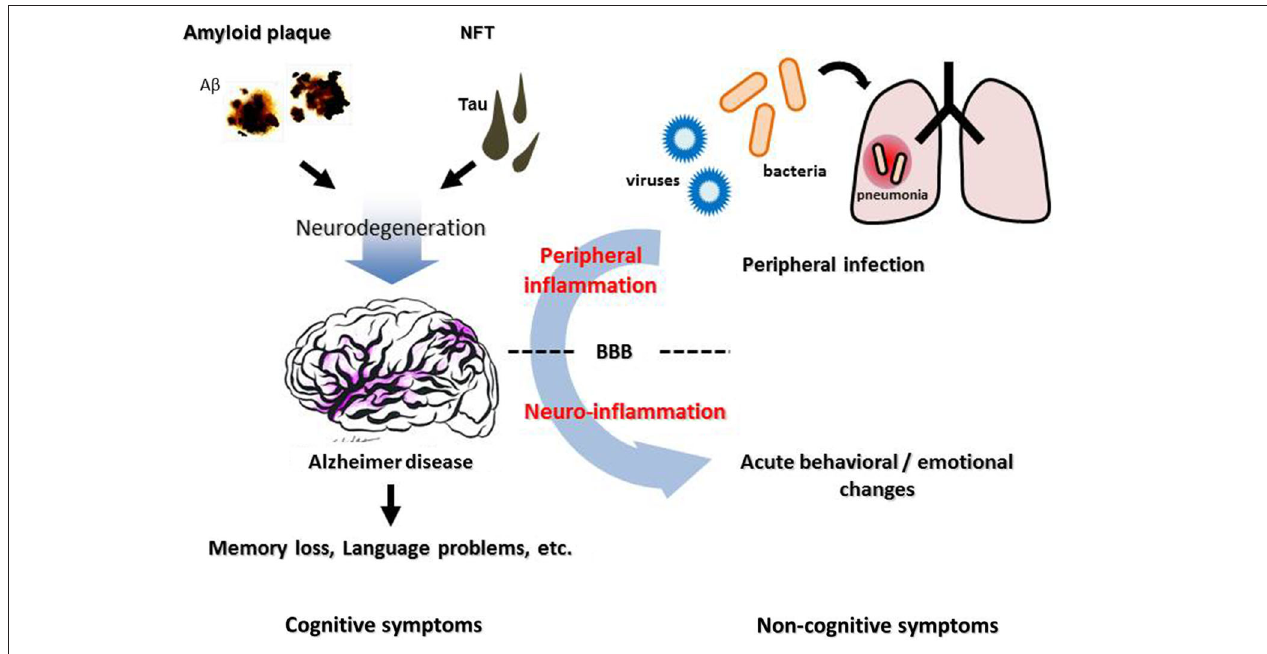
symptoms, such as agitation, aggression and psychosis, are often observed in AD patients, besides cognitive deterioration. These symptoms can be triggered by an infection in peripheral organs such as pneumonia, suggesting a contribution of peripheral inflammation. BBB, blood-brain